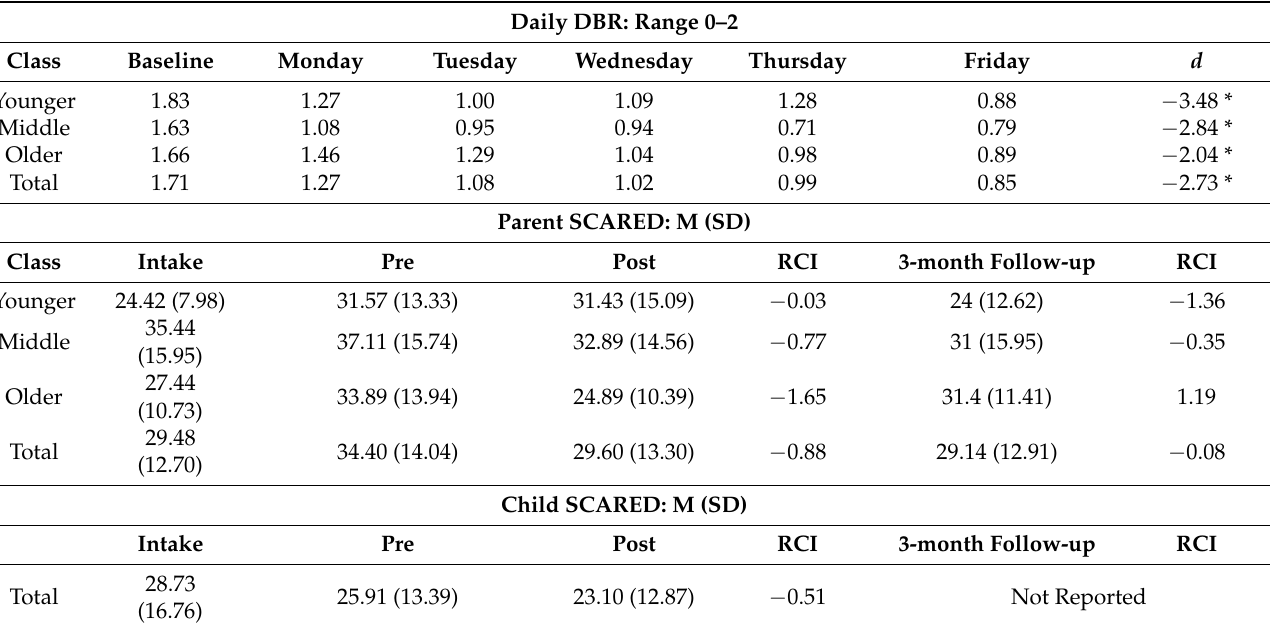
Table 3. Aggregated Anxiety